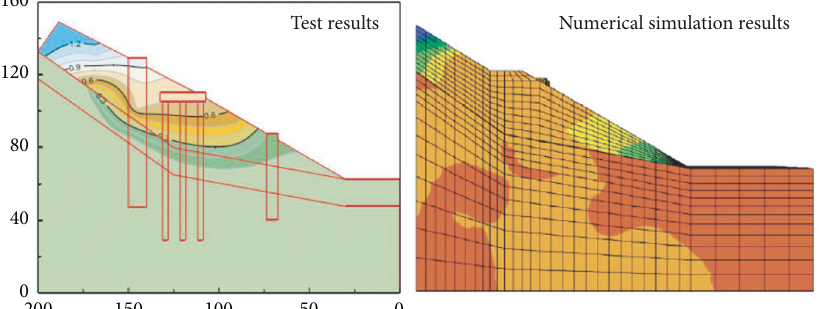
Figure 26: Horizontal displacement field comparison between numerical simulation and model test of the reinforced front and rear antislide piles in the sliding section of bridge